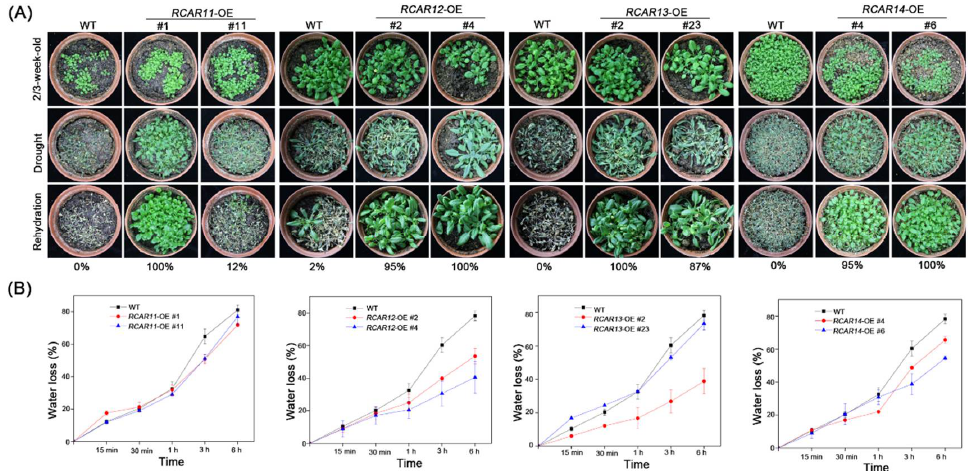
Figure 4. The RCAR11/12/13/14 are involved in the tolerance of Arabidopsis to drought stress. ( A ) Drought tolerance assay. Two-week-old seedlings were performed by withholding water for 13 days and subsequently re-watering for 2 days. The survival rates of WT and transgenic plants after drought and rehydration for 2 days. Four independent measurements were performed. The photographs show the representative measurement; ( B ) Water loss rates. Rosette leaves from 3-week-old plants were detached and the fresh weights were measured at the indicated time points. Three independent measurements were taken. Values are means ± SD ( n = 6).